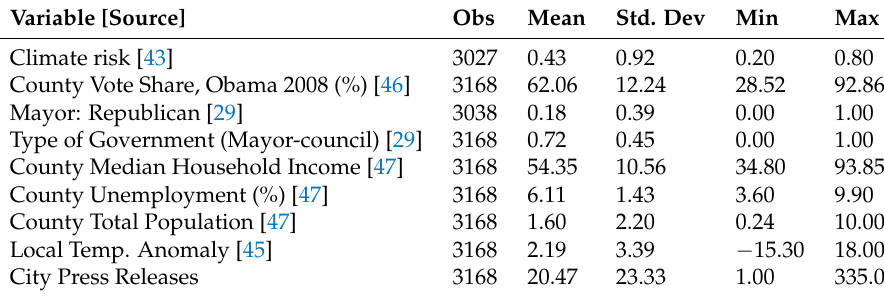
Table 2. List of key